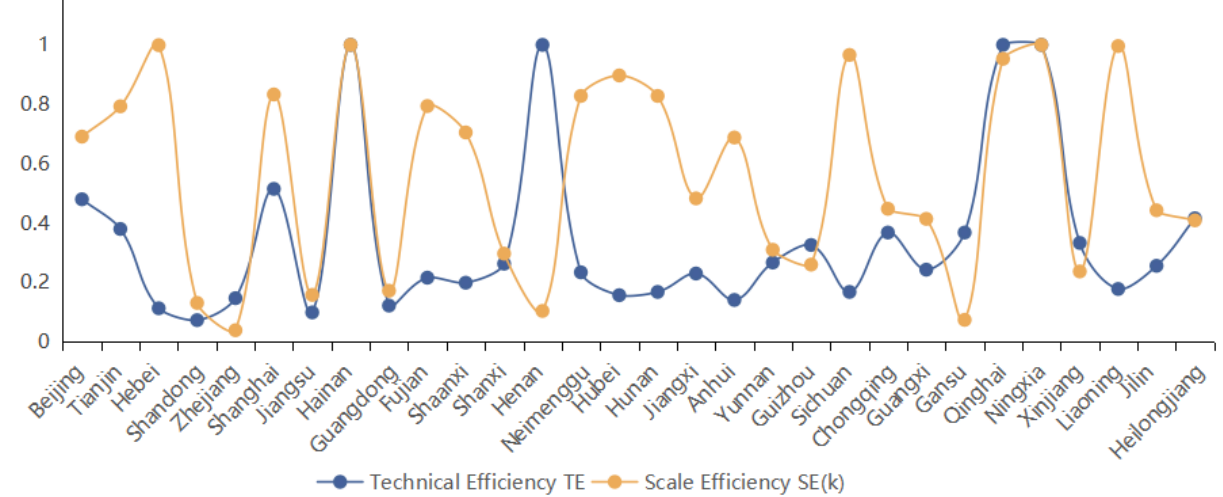
Figure 2. Technical efficiency and scale efficiency of 30 cities.